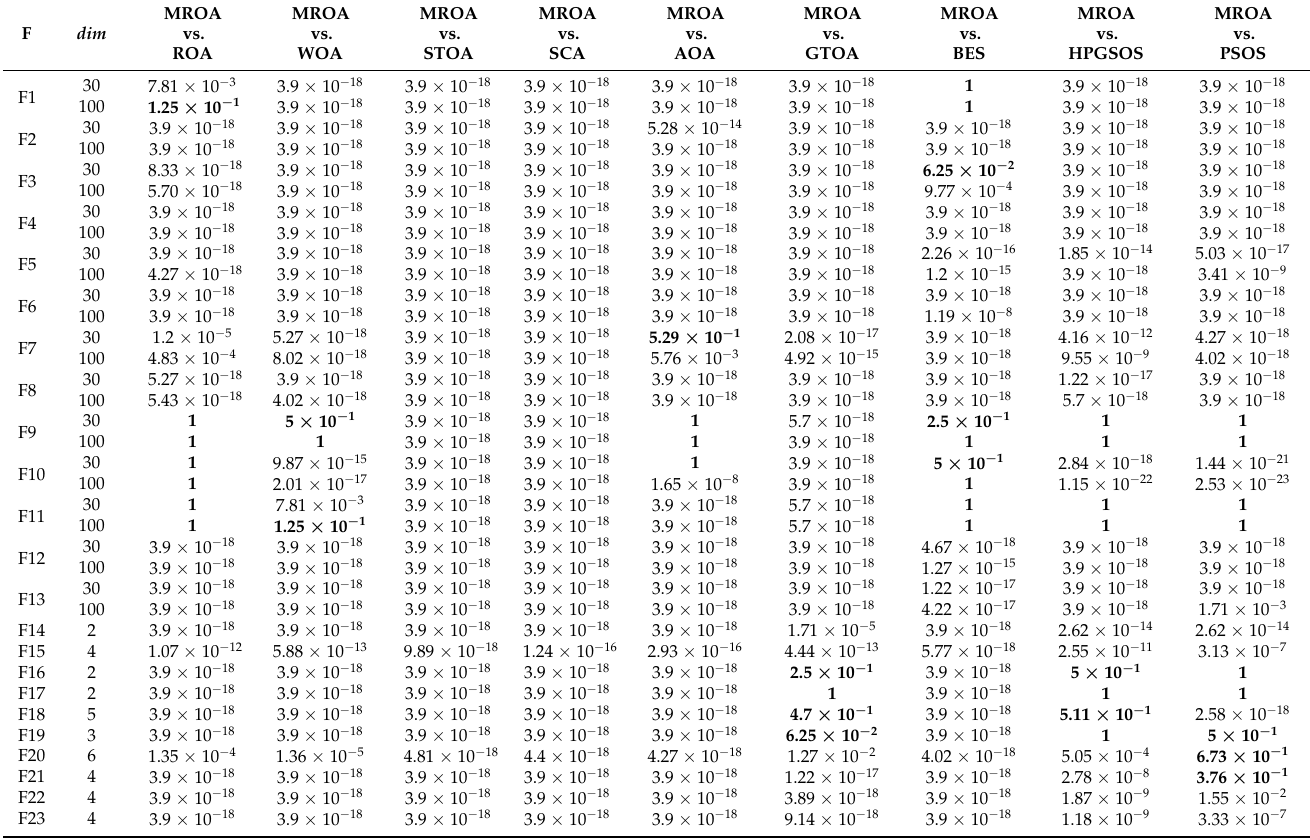
Table 5. The Wilcoxon signed-rank test results between MROA and other metaheuristic algorithms on test functions (F1–F23) in low dimensions (run 100 times). (Bold makes the Wilcoxon rank-sum test more effective).